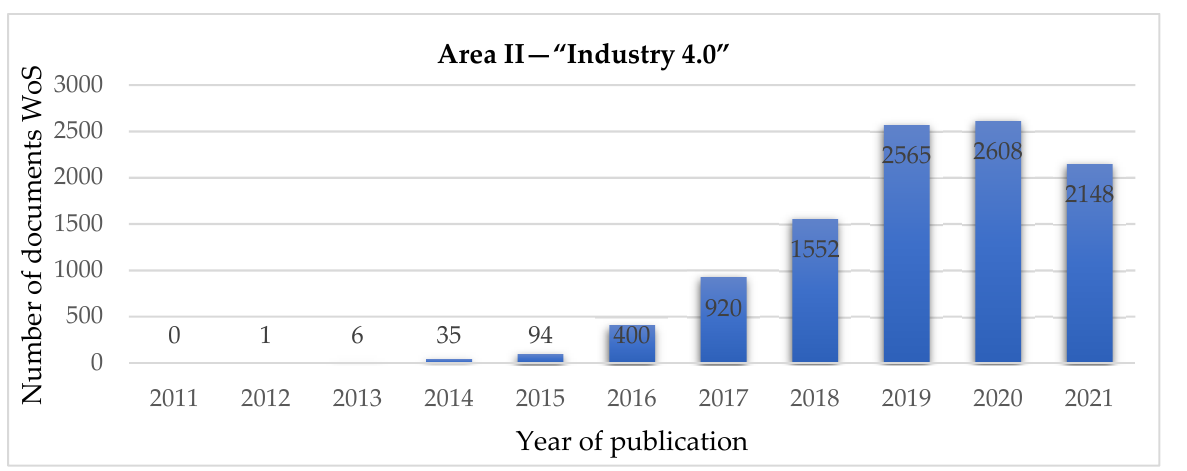
Figure 3. The dynamics of growth of published articles in the WoS database from 1 January 1996 to 31 October 2021 in the field of business models. Source: own elaboration.